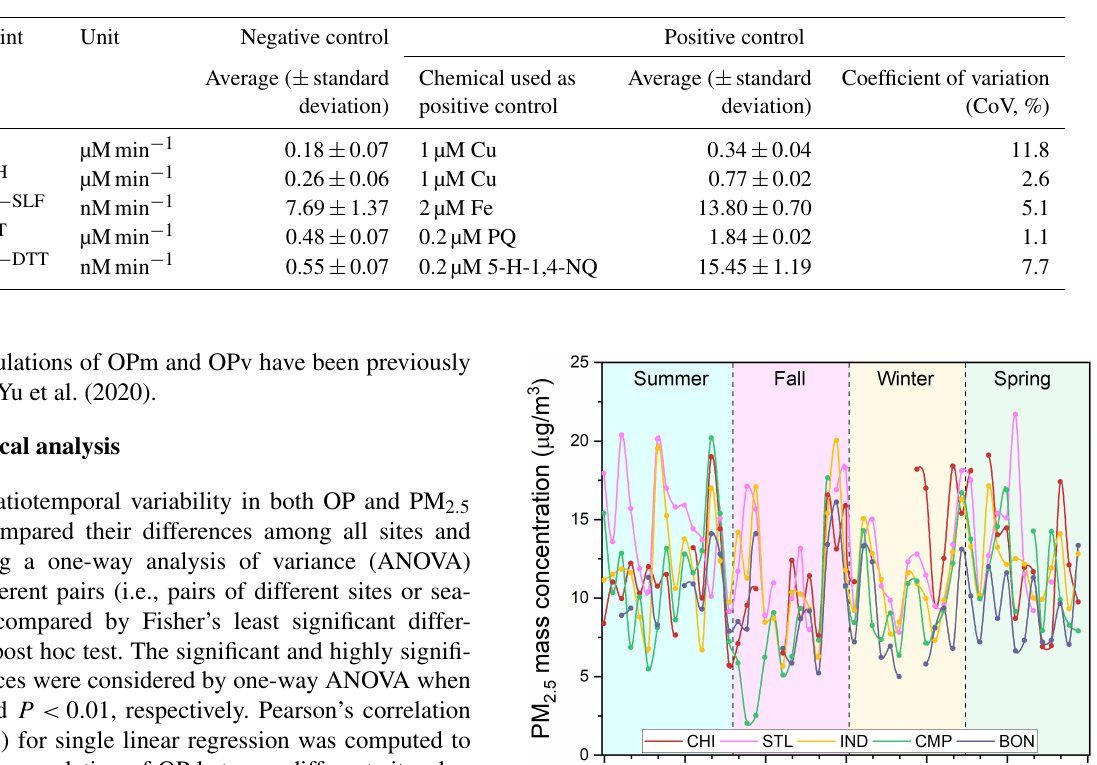
Table 1. Averages ( ± standard deviation) of OP from various control groups ( N = 10) analyzed by SAMERA.